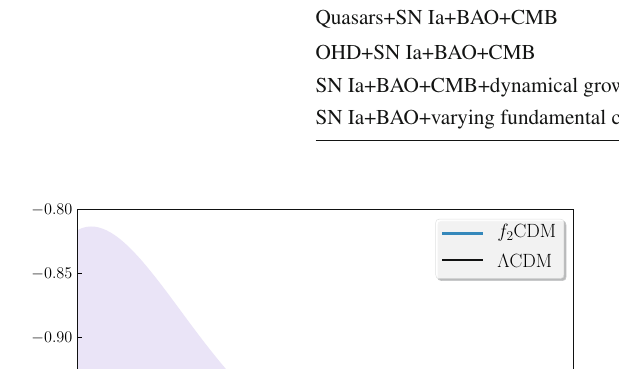
Fig. 4 1 σ and 2 σ confidence regions for the f 2 CDM model. The red lines represent contour plot given by quasars ( left panel ) and SN Ia ( right panel ). The black lines represent constrained result from the joint analysis quasars+BAO+CMB ( left panel ) and SN Ia+BAO+CMB ( right panel ) Table 3 Summary of the Data best-fit values of parameters for the f 2 CDM model with 1 σ uncertainties for different observations